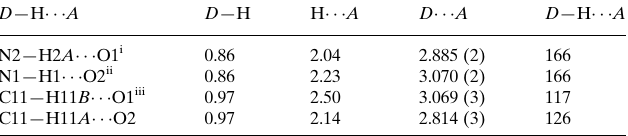
Hydrogen-bond geometry (A˚ , (cid:2)